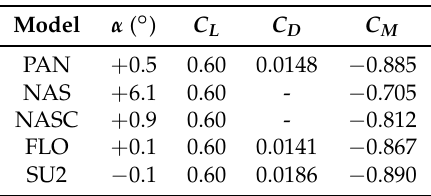
Table 9. Angles of attack and aerodynamic coefficients for the flexible Embraer wing at Mach 0.78 and lift coefficient 0.60 obtained from different levels of